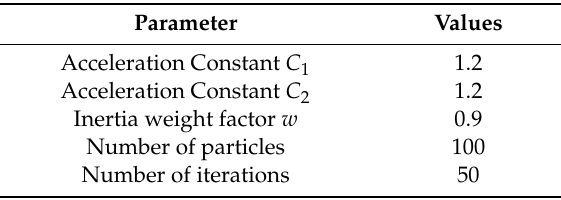
Table 2. Parameters of particle swarm optimization (PSO).